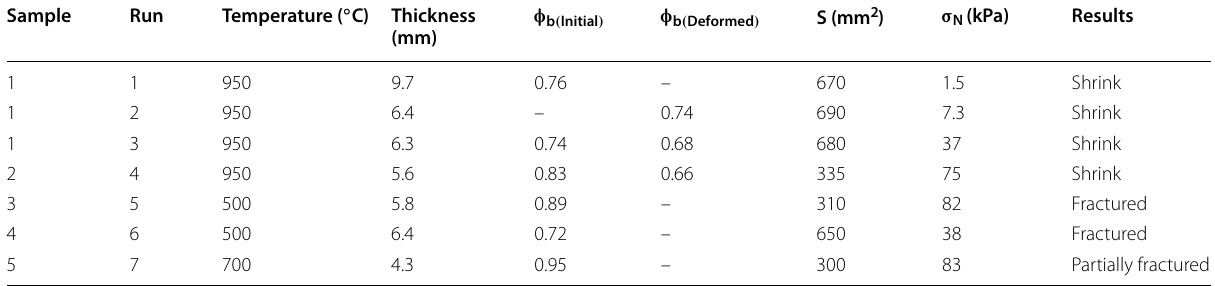
S is the surface area of the scoria, and σ N is normal stress to be imposed